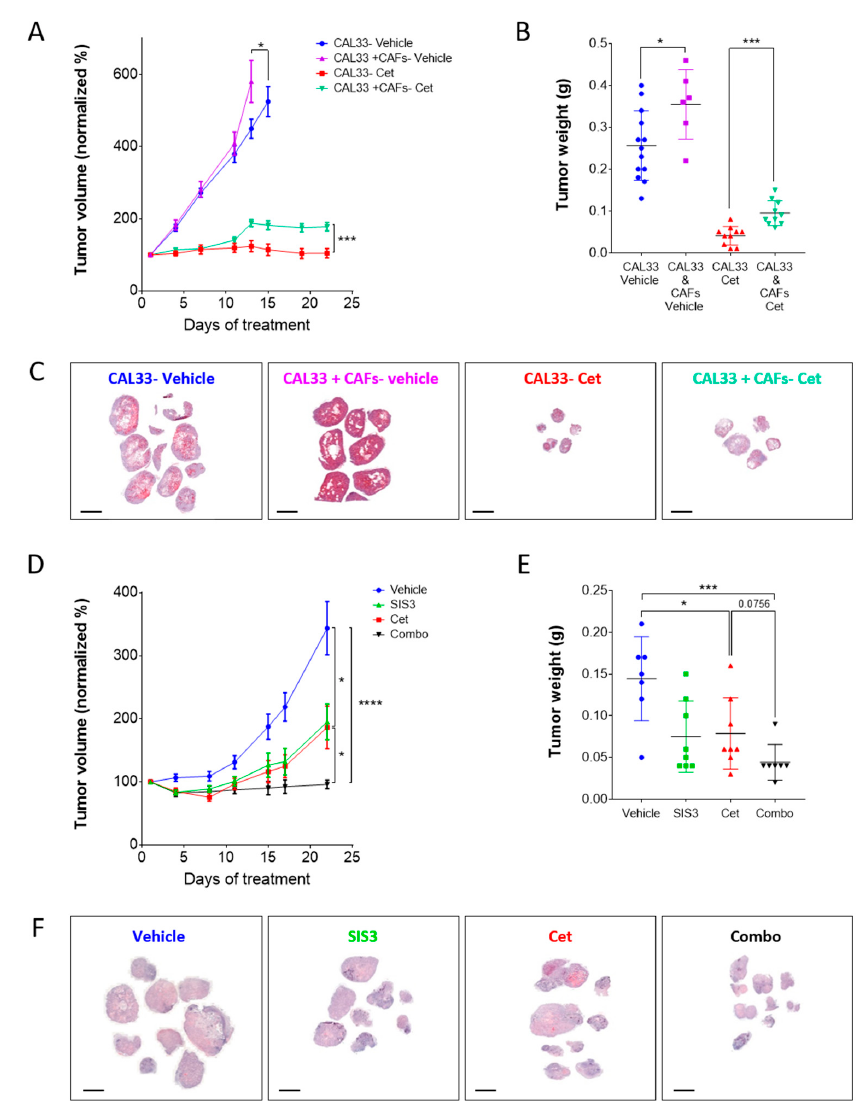
Figure 4. TGF-beta-activated CAFs reduce sensitivity to cetuximab in vivo, and blocking TGF-beta sensitize HNC-PDX to cetuximab. ( A ) The tumor volume of the CAL33 xerograph model with or without CAFs isolated from PDX #19. 10 6 cells from each cell line (CAL33 tumor cells, PDX #19 CAFs) were injected subcutaneously in NOD / SCID mice. Mice were randomized into 4 arms (tumors, n = 8–16) and treated with cetuximab (10 mg / kg / 5d) via intraperitoneal injection or vehicle. The average tumor volumes ± SEM are presented. Statistical significance was calculated by unpaired t -test (* p < 0.05 and *** p < 0.001). ( B ) Tumor weights of the 4 arms. Statistical significance was calculated by unpaired t -test (* p < 0.05 and *** p < 0.001). ( C ) H&E staining. Scale bar: 0.3X, 5000 µ m. ( D ) Tumor volume of Cetuximab Prog -PDX (PDX #18). Mice were randomized into 4 arms (tumors, n = 7–8) and treated with vehicle or cetuximab (10 mg / kg / 5d) and / or SMAD3 inhibitor SIS3 (5 mg / kg / d) via intraperitoneal injection. The average tumor volumes ± SEM are presented. Statistical significance was calculated by unpaired t -test (* p < 0.05, *** p < 0.001, and **** p < 0.0001). ( E ) Tumor weights of the 4 arms. Statistical significance was calculated by unpaired t -test (* p < 0.05 and *** p < 0.001). ( F ) H&E staining. Scale bar: 0.3X, 5000 µ